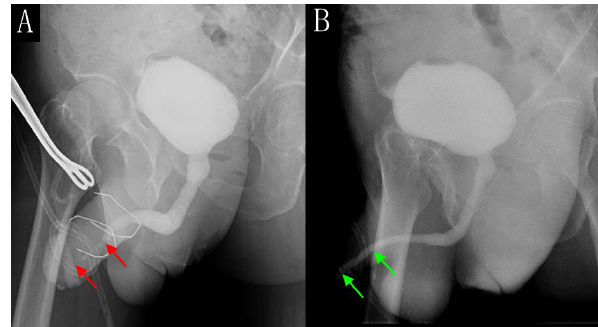
Fig. 2. Retrograde urethrogram of Patient A. (A) Preopera- tively, the penile urethra was narrow (between the two red arrows), and the mucosa was incomplete for approximately 5.5 cm from the external urethral orifice. (B) Postoperatively, the urethra was un- obstructed, the inner diameter was wide, and there was no stenosis or diverticulum (between the two green